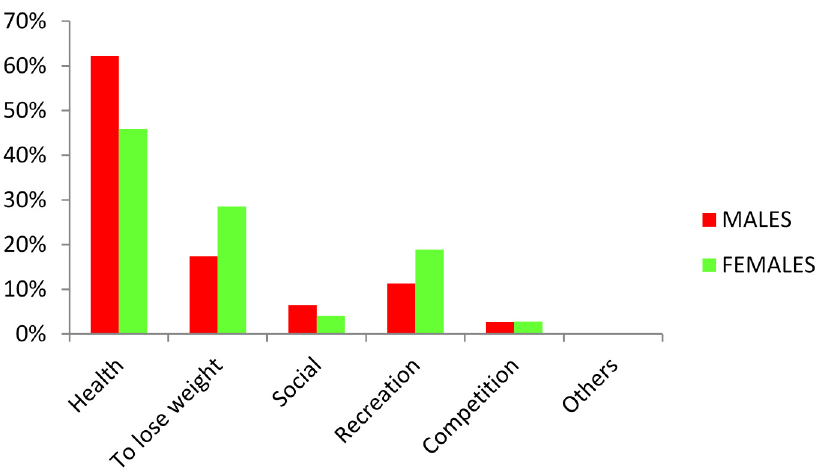
Figure 3. Reasons for regular participation in physical activities or sports.